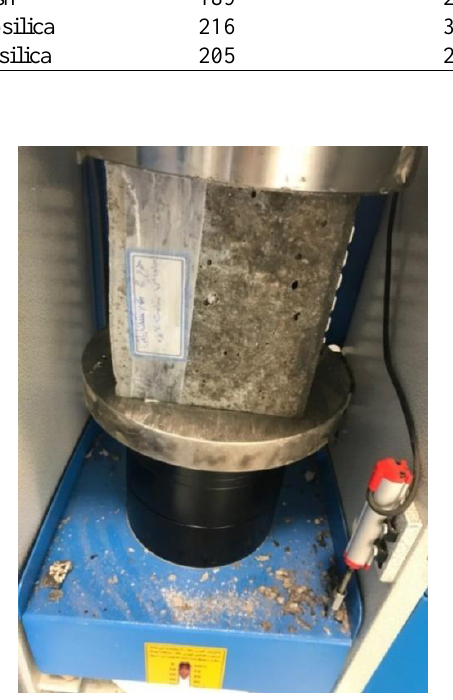
Figure 5. An example of concrete with rice husk ash containing recycled aggregate .